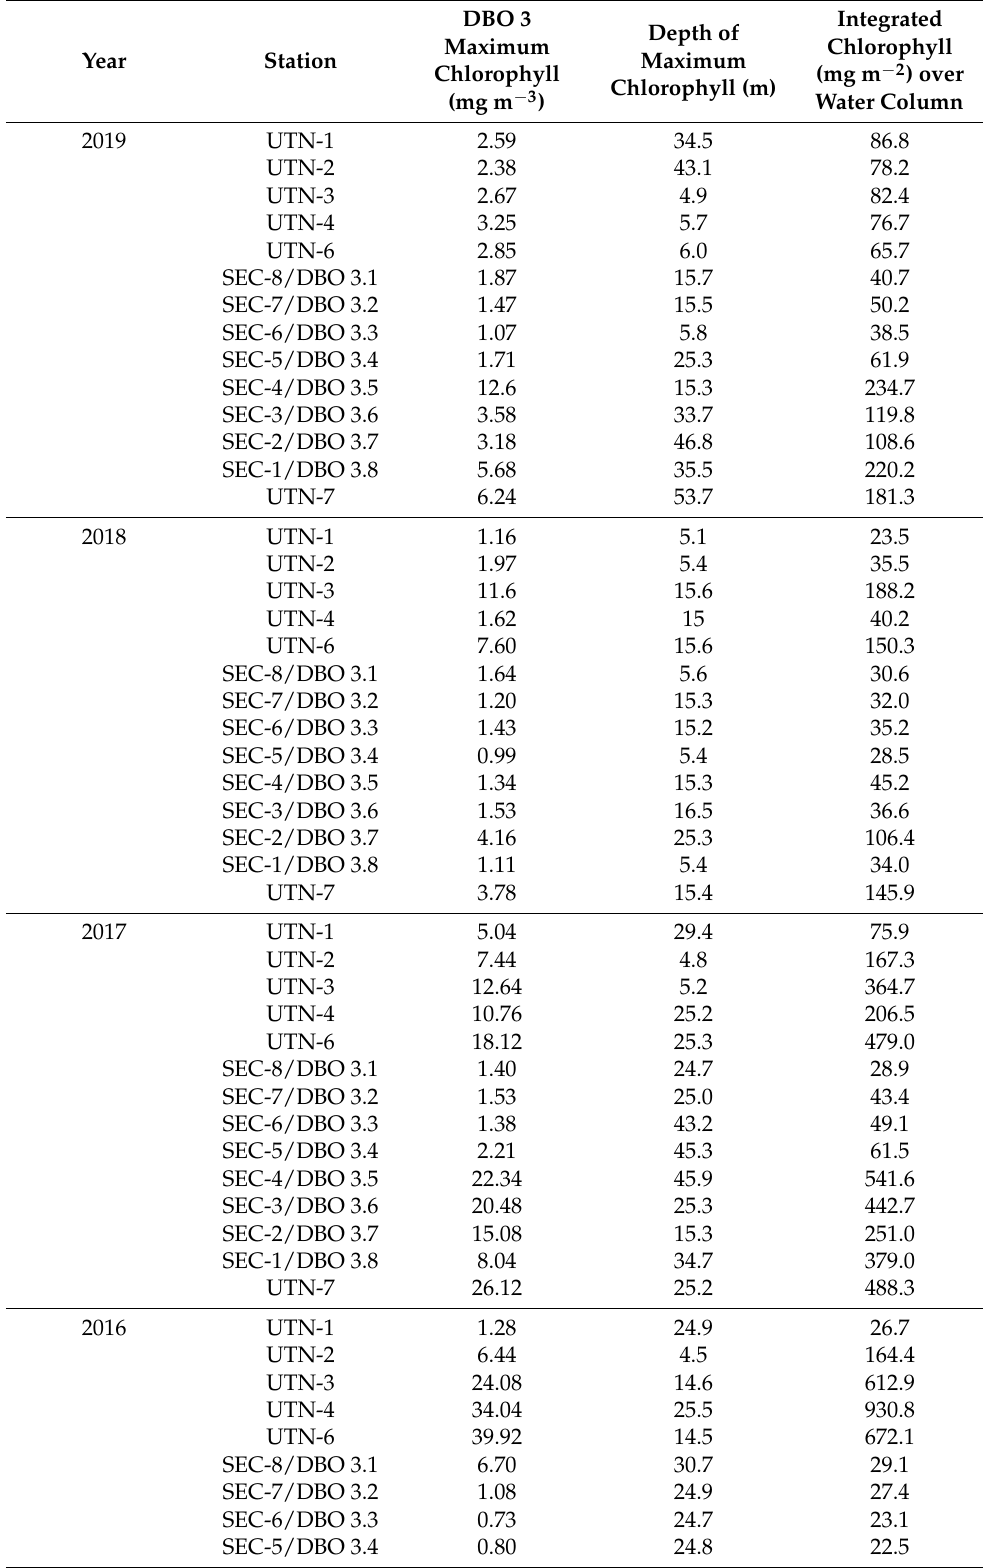
Table 3. DBO stations north of Bering Strait; “hot-spot”